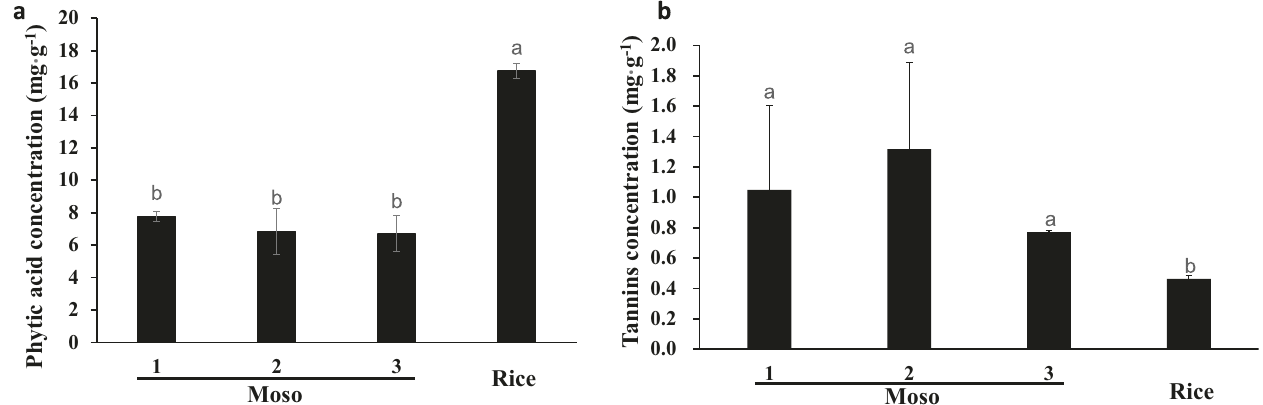
Fig. 3 Phytic acid and tannins concentration in Moso bamboo seeds and rice. a Phytic acid concentration in Moso bamboo seeds and rice. b Tannins concentration in Moso bamboo seeds and rice. Data are means ± SD ( n = 4). Statistical comparison was performed by one-way ANOVA, followed by Tukey ’ s multiple comparison test. Different lower-case letters indicate signi fi cant difference at P <